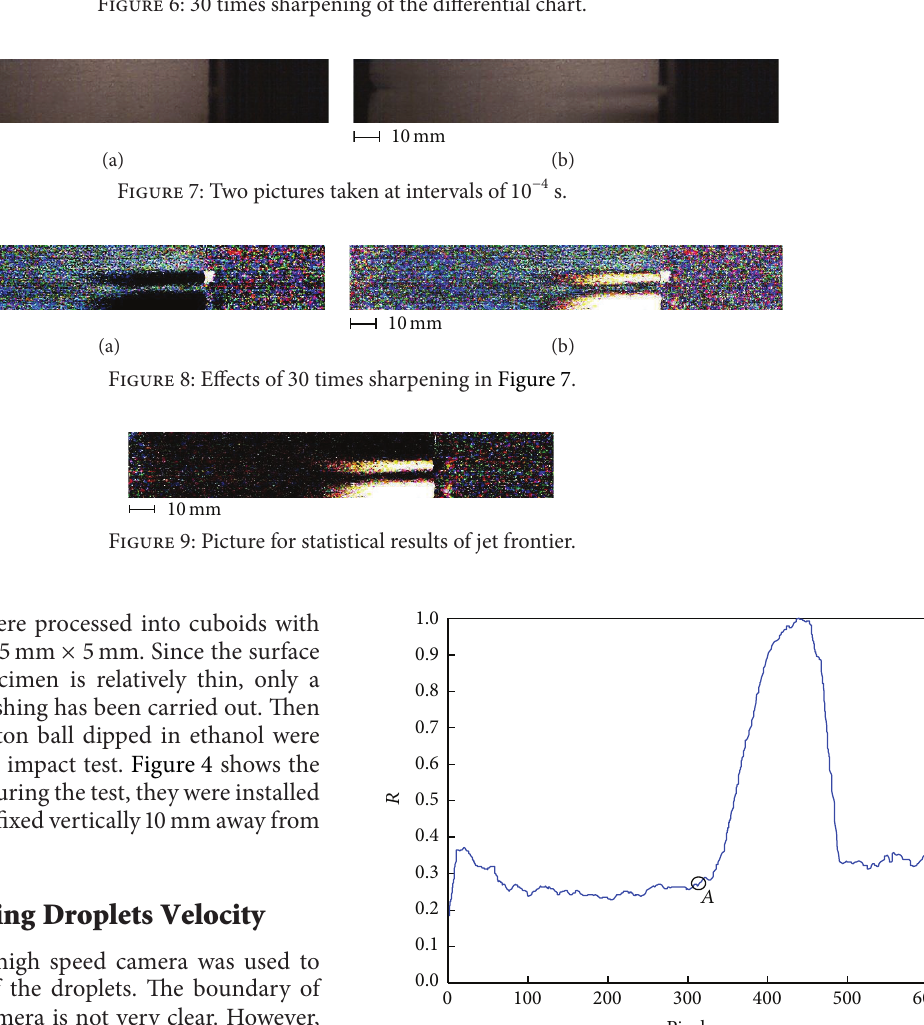
Figure 10: Distribution of the filtered 𝑅 with the horizontal position of the